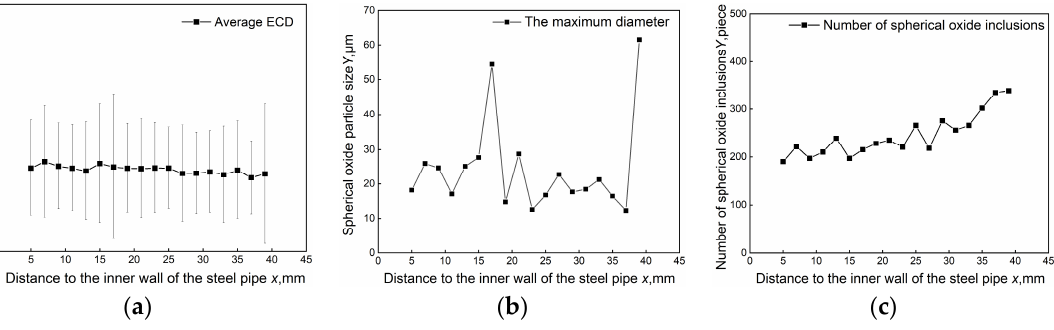
Figure 4. Average ECD values in graphic ( a ), maximum size in graphic ( b ) and quantity of spherical oxide inclusions in graphic ( c ) along the cross-section of sample 1#.